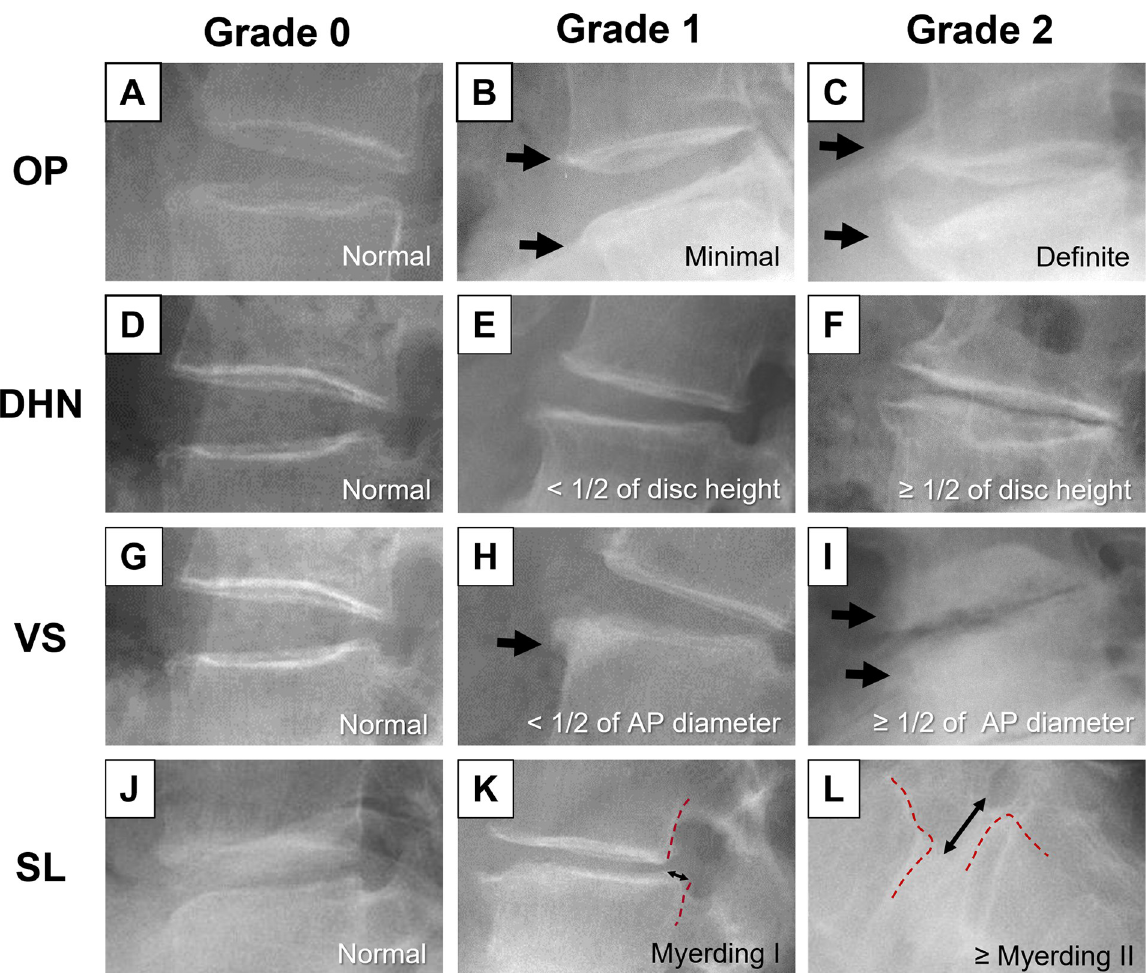
Fig 1. Typical radiographic features for the novel elemental grading system. Osteophytes (OP) were classified as grade 0, normal (A); grade 1, minimal anterior vertebral osteophytosis (B); and grade 2, definite vertebral osteophytosis (C). Disc height narrowing (DHN) was classified as grade 0, normal (D); grade 1, mild (less than 1/2 of estimated disc height) DHN (E); and grade 2, severe (equal to or more than 1/2 of estimated disc height) DHN (F). Vertebral sclerosis (VS) was classified into grade 0, normal (G); grade 1, mild (less than 1/2 of anteroposterior diameter) sclerosis (H); and grade 2, severe (equal to or more than 1/2 of anteroposterior diameter) sclerosis (I). Spondylolisthesis (SL) was classified into grade 0, normal (J); grade 1, Meyerding [15] grade I (K); and grade 2, Meyerding grade II or worse (L).